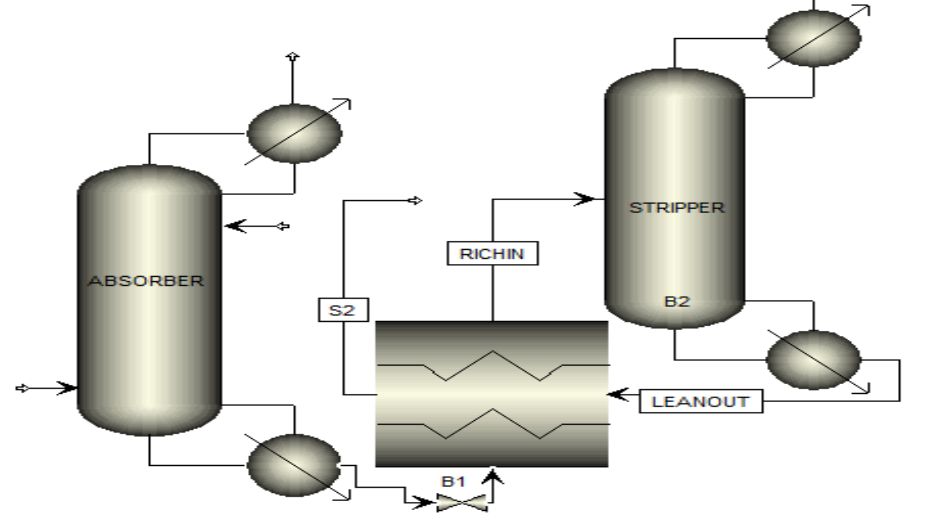
Figure 7. Amine treatment process in ASPEN Plus.